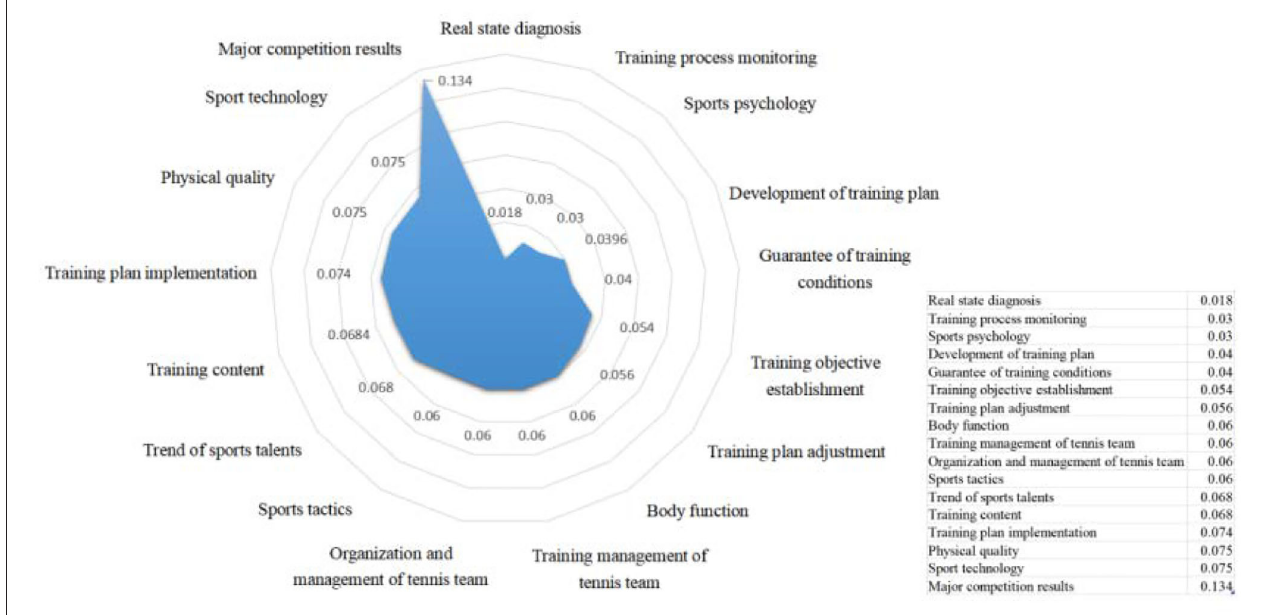
FIGURE 4 | Ranking order of secondary index weight in training quality evaluation of high-level tennis